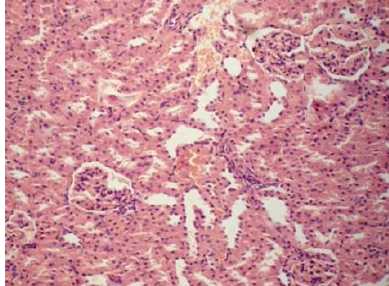
Fig. 3. Cortical substance of SHR rat kidney. Incomplete renal tubules. Staining with hematoxylin and eosin. Eye. 10×. Lens. 10×.